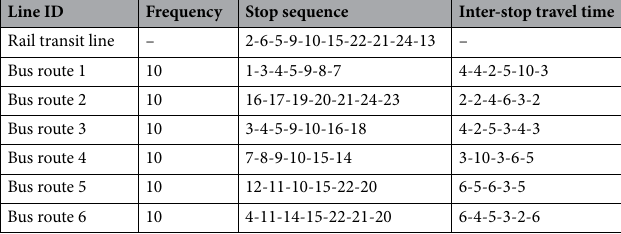
Table 2. Initial transit line data.